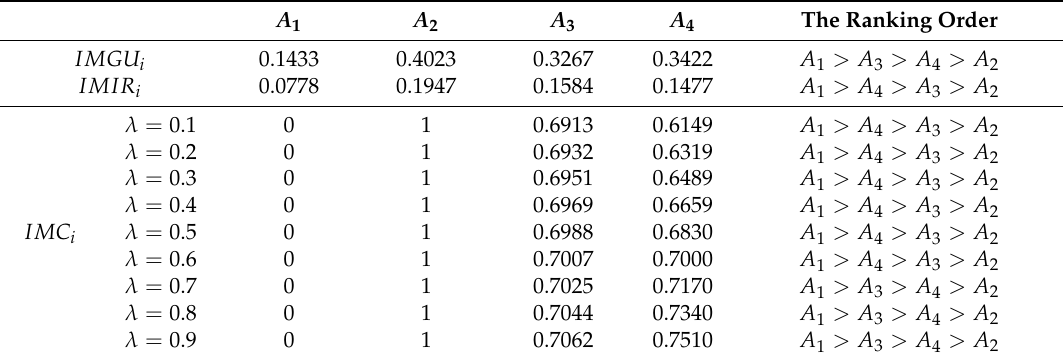
Table 10. The calculation results of the IM-VIKOR